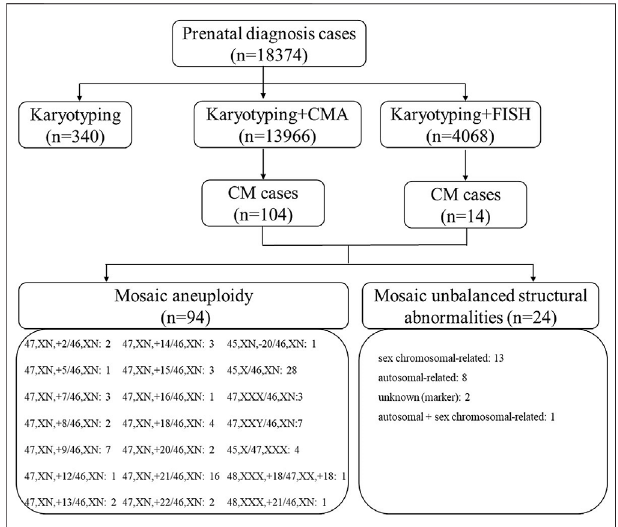
FIGURE 1 | Flow chart of fetuses with CM at our center in a fi ve-year period between January 2016 and December 2020. CM, chromosomal mosaicism; CMA, chromosomal microarray; FISH, fl uorescence in situ hybridization; T,